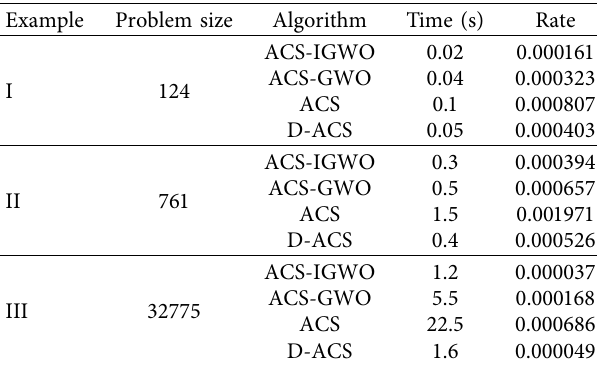
Table 15: Comparison of algorithms of different node cases.